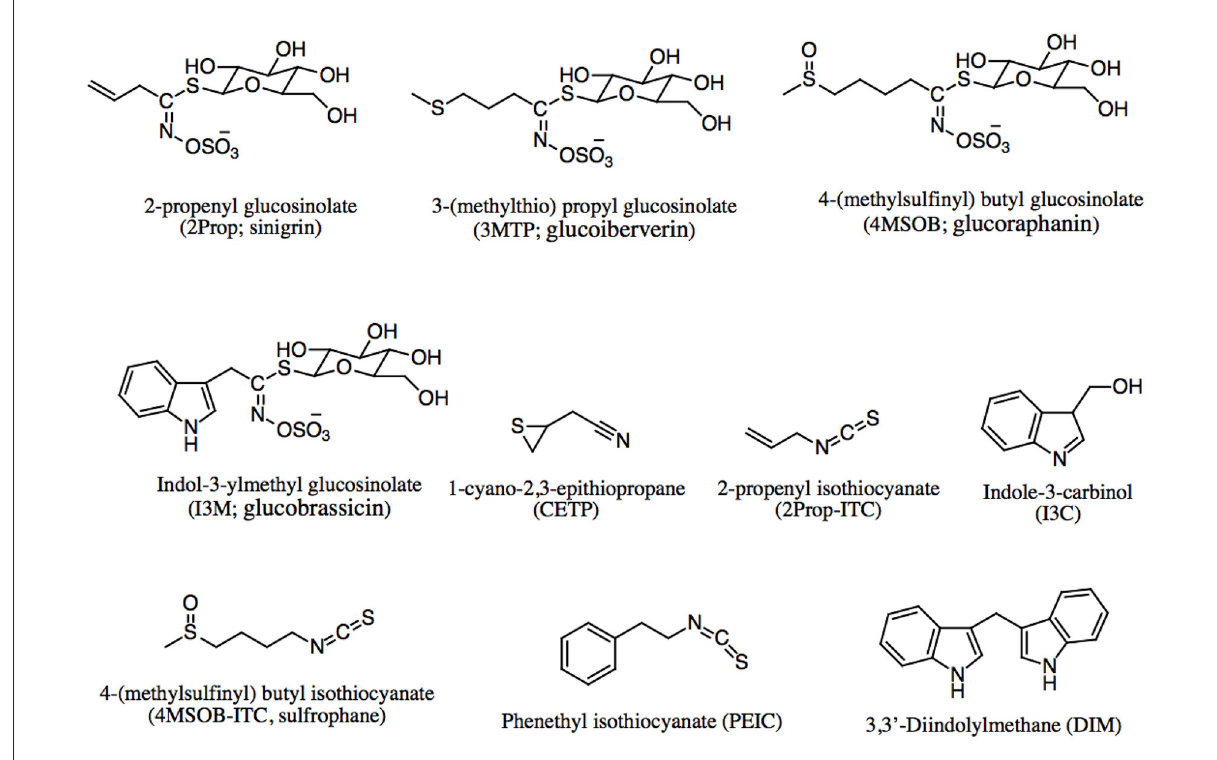
FIGURE2 Chemical structures of glucosinolate and their breakdown products.